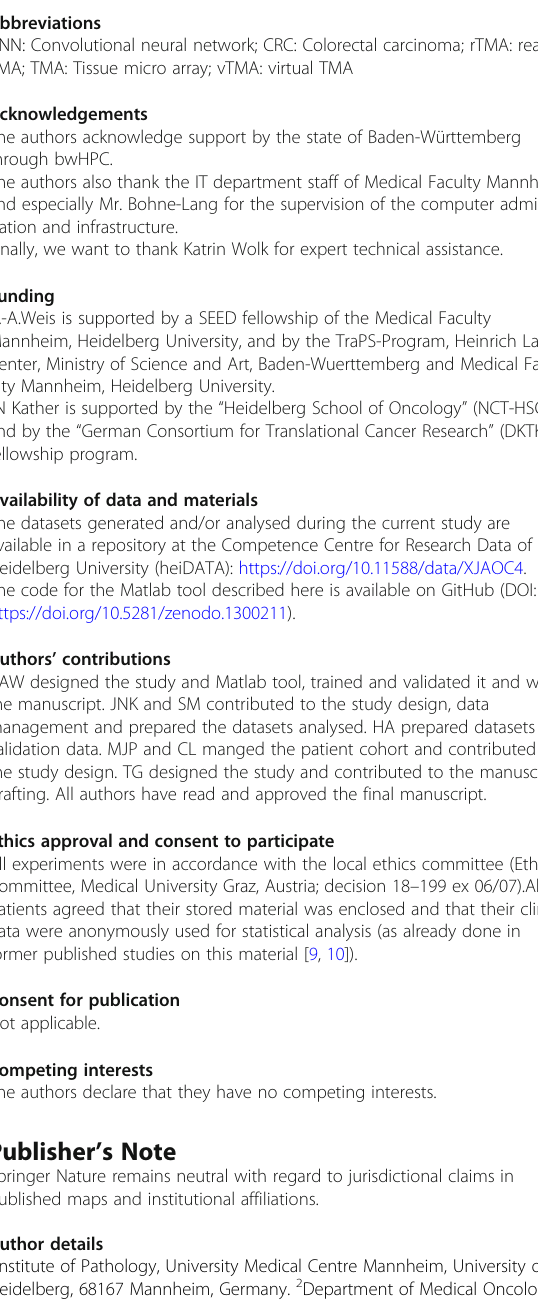
Additional file 5: Figure S1. Validation of the detection method on 20 test cores. In 10 real TMA cores (rTMA) and 10 virtual TMA-cores (vTMA) every tumor bud has been manually segmented in Fiji [23] as ground truth. (PDF 9248